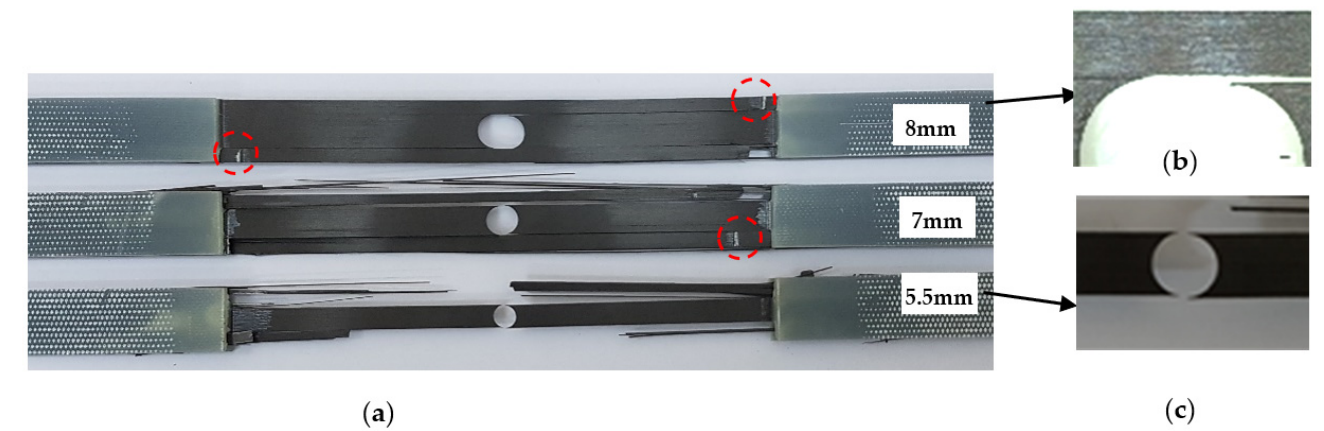
Figure 13. The change in the number and amount of stress relaxation with hole diameter.